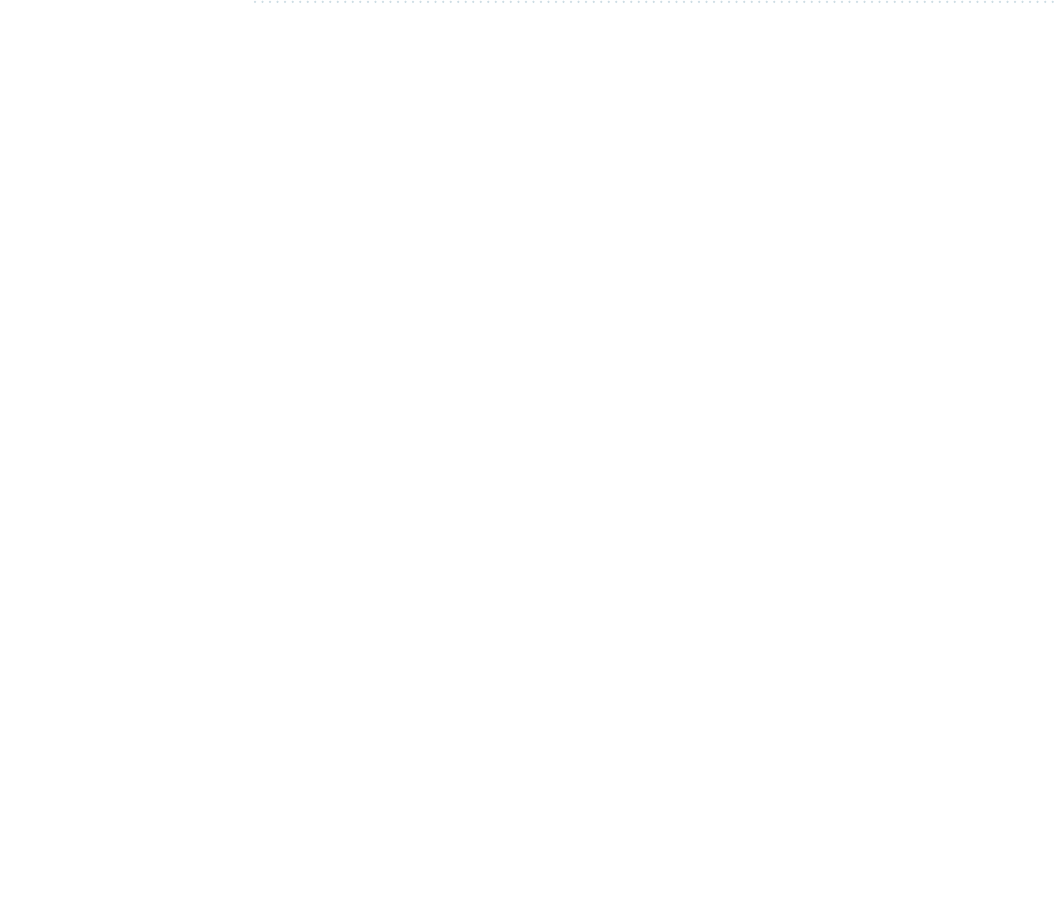
Table 2. Treatment regimen, response, time to response, total duration of treatment and adverse events of the drug were analysed. Pred prednisolone, CysA cyclosporin A, RTX rituximab, PR partial response, CR complete